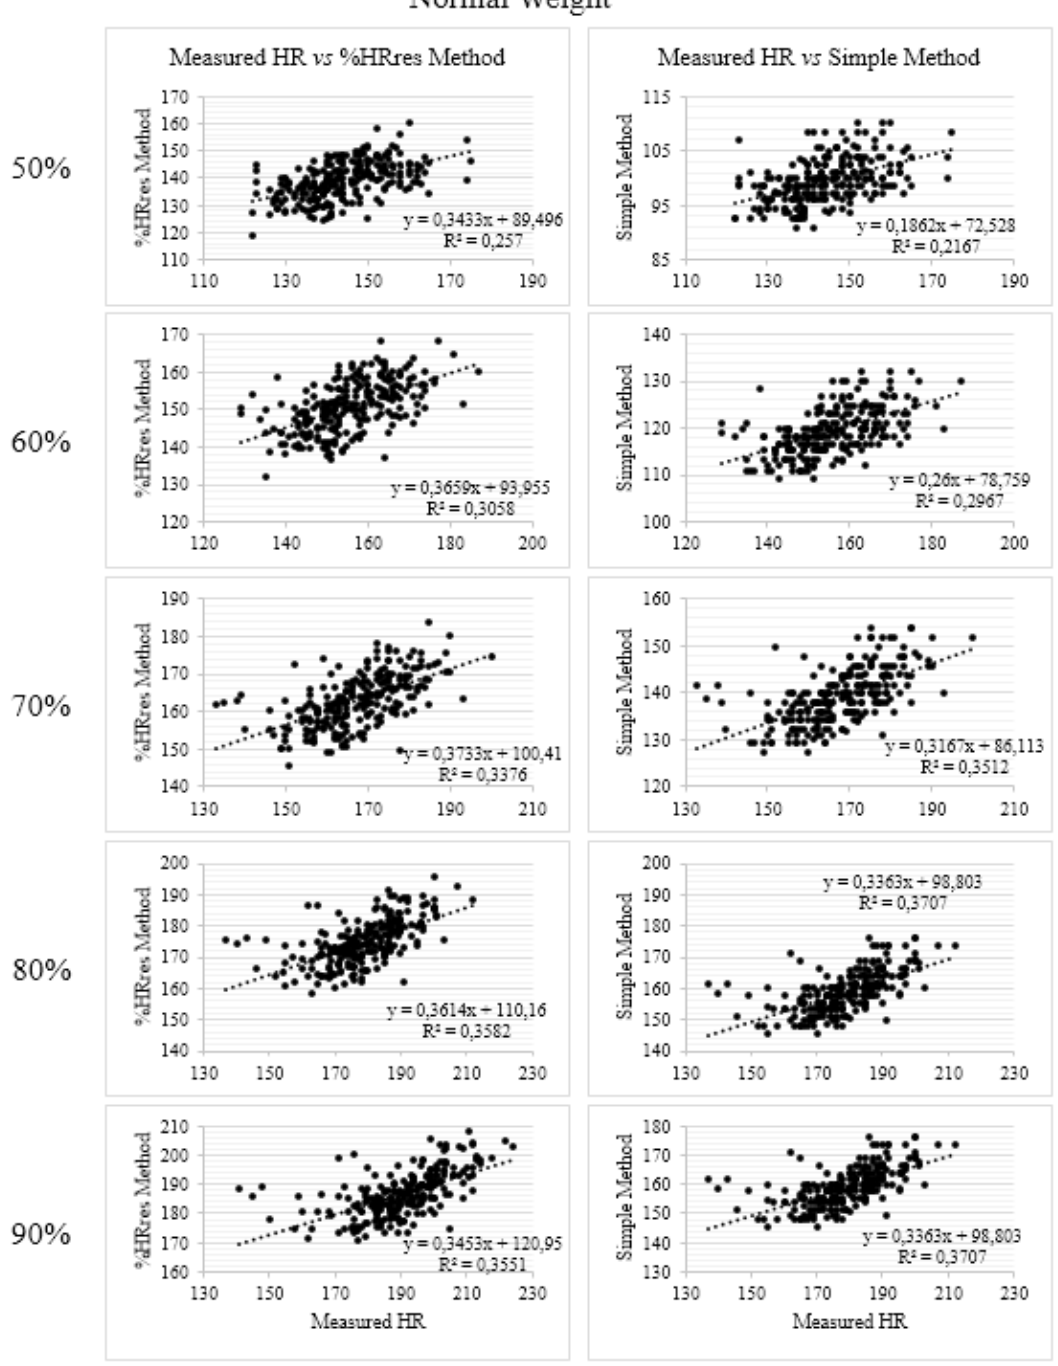
Figure 1. Correlation between measured HR vs. predicted %HRres method and measured HR vs predicted simple method (HRmax) in normal weight for both sexes